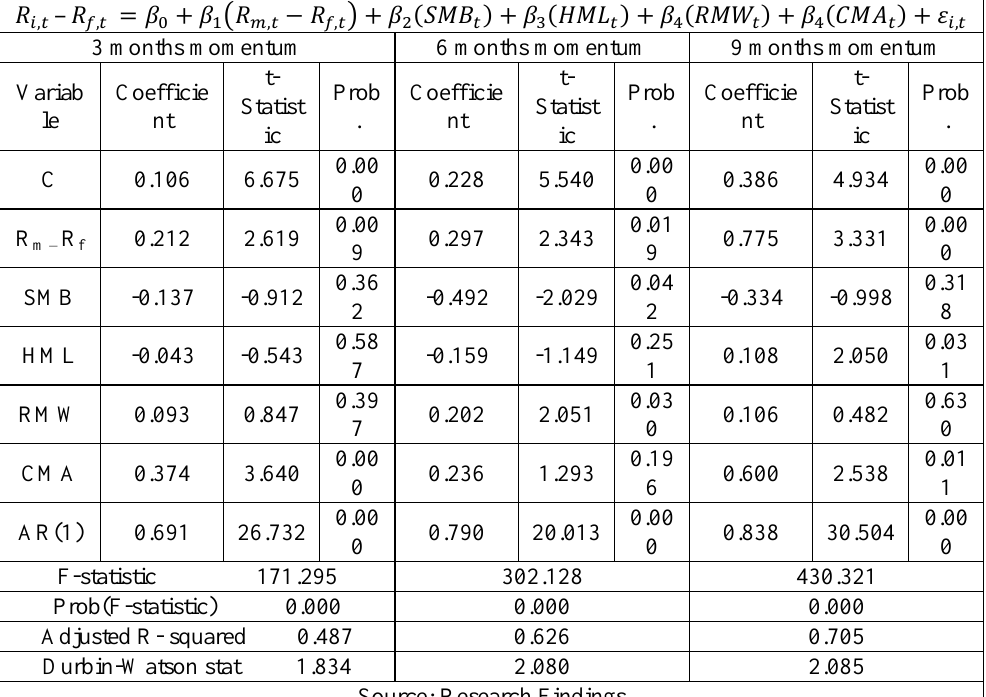
Table 7. Regression results for the effect of anchoring bias in stocks with low liquidity on momentum profit using the Fama-French model (